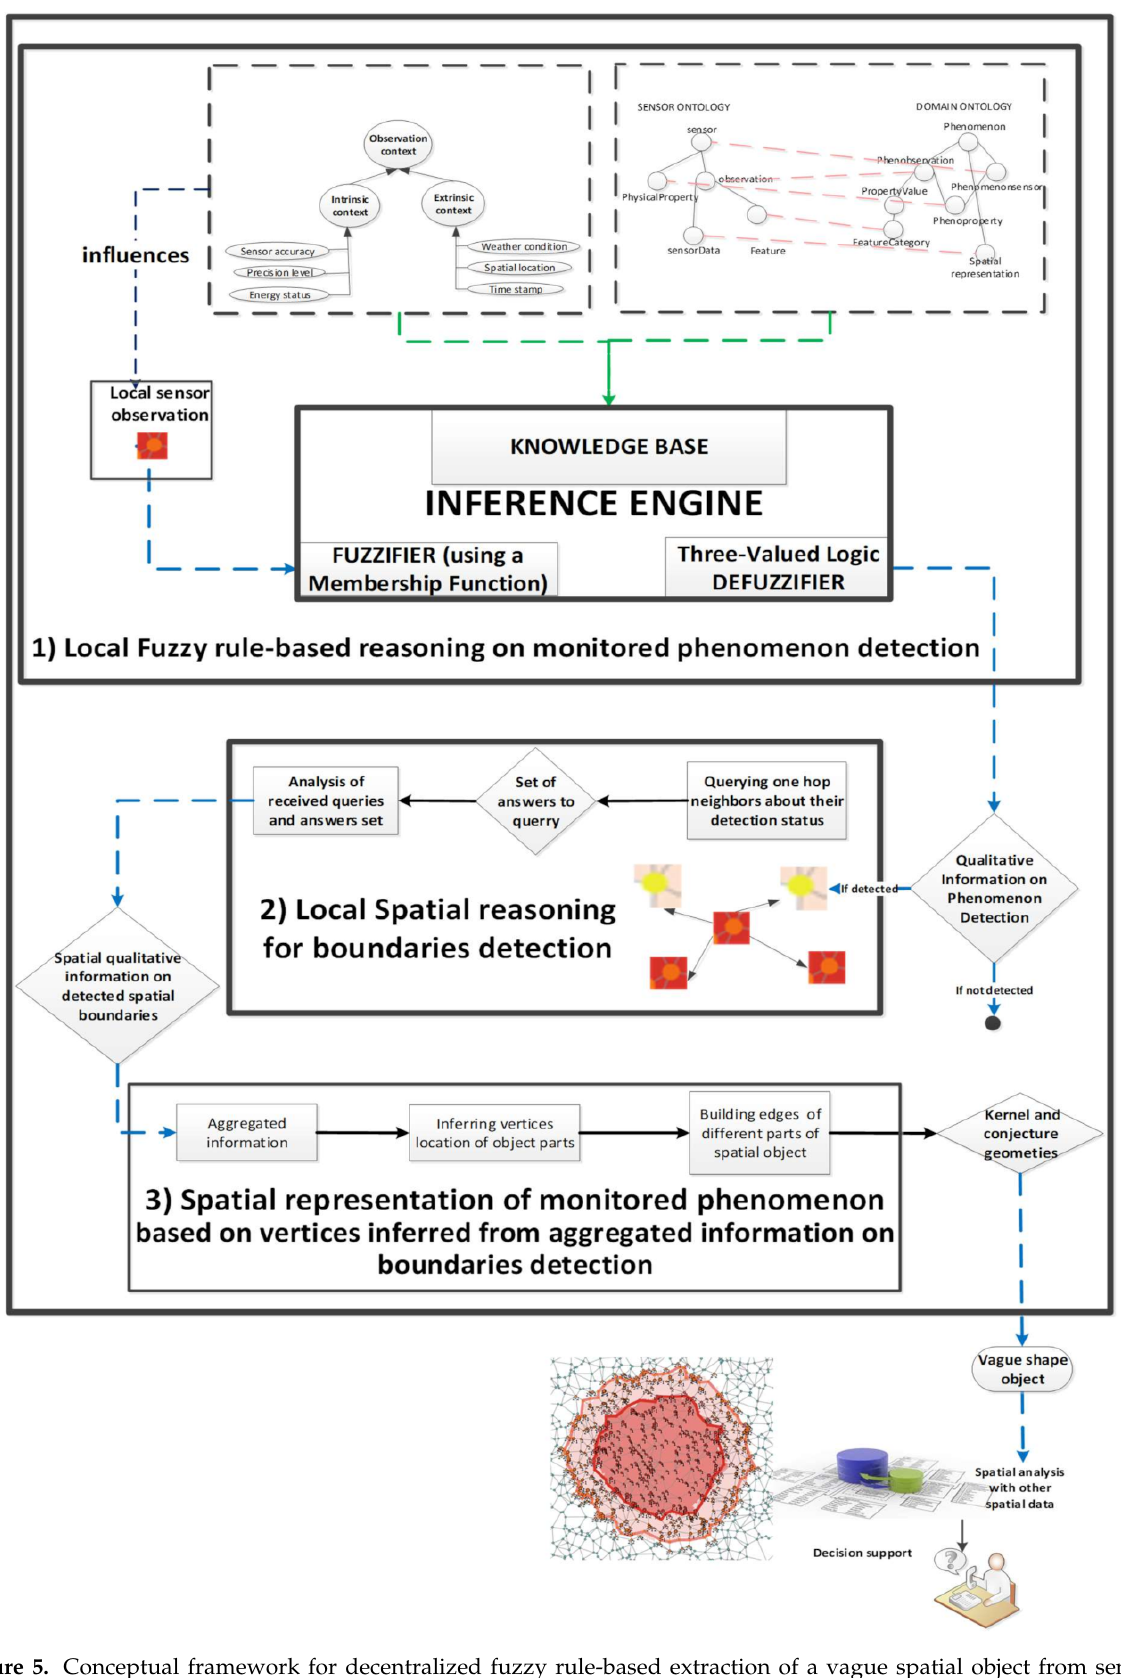
Figure 5. Conceptual framework for decentralized fuzzy rule-based extraction of a vague spatial object from sensor network